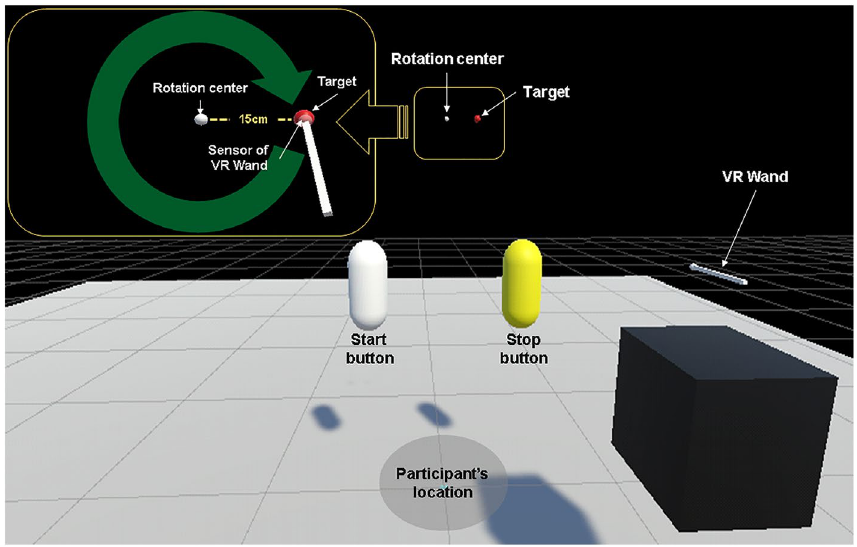
Figure 1. VR rotary pursuit (VRRP) task. In the VRRP task, after touching a start button and holding the VR wand, participants were required to manipulate the controller so that the VR wand sensor contacted a red target moving in a clockwise direction with a radius of 15 cm at a constant